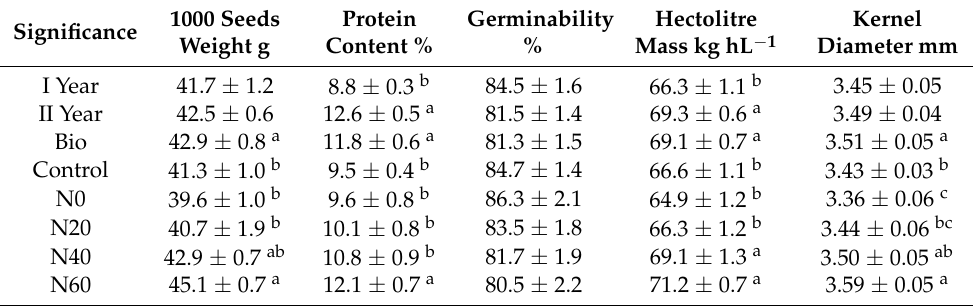
Table 5. Average seed weight, protein content, germinability, hectolitre mass, and diameter of barley kernels as affected by growing season (2018–2019 = I Year; 2019–2020 = II Year), biostimu- lant (treated with biostimulant = Bio and not treated = Control) and nitrogen fertilization levels (not fertilized = N0; fertilized with 20 kg N ha − 1 = N20; fertilized with 40 kg N ha − 1 = N40 and fertilized with 60 kg N ha − 1 = N60). Different letters indicate significant differences according to the Duncan test ( p < 0.05).